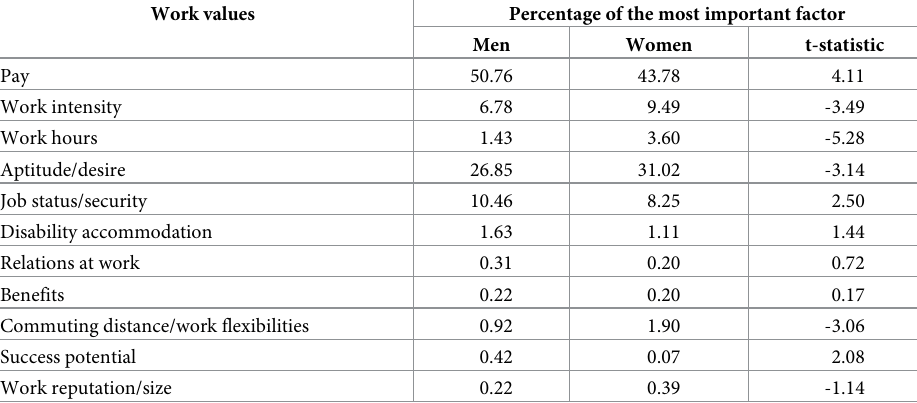
Table 3. By testing the null hypothesis of H Table 2. The most important aspects of